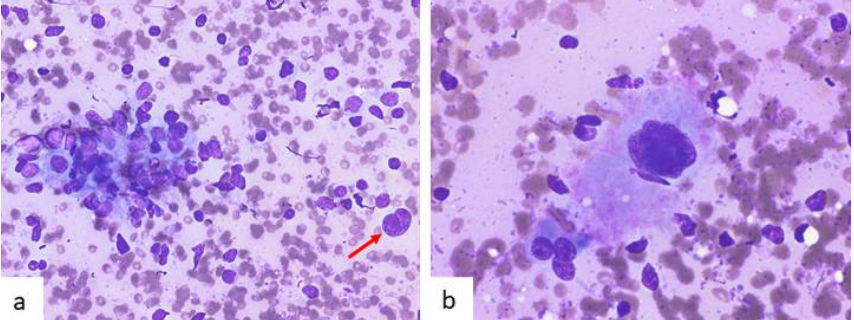
Figure 4. Cytological images in case of HV-CD. ( a ) The image shows an aggregate of FDCs (left) as well as a large single one with no cytoplasm and a nuclear indentation (red arrow) (Diff-Quik, ×200). ( b ) Some FDCs are dysplastic with very large size and irregular nuclear contours (Diff-Quik, ×600). Most nuclei have regular borders with fine chromatin, small nucleoli and occasional binucleation. Hidvegui et al. described a peculiar coarse chromatin (“wrinkled tissue pa- per”) [47] that has been rarely reported by others [67,68]. Nucleoli sometimes can be large, and nuclear grooves and indentations can be prominent (Figure 4). Large binucleated cells with relevant nucleoli may be misinterpreted as Reed–Sternberg cells [53,56,60]. In fact, HL is one of the main pitfalls in the cytological diagnosis of CD. An extreme form of FDC change are the so-called giant “dysplastic” cells. They are also present in the PC variant of CD. At least one cytological report described them [50] . Smears rarely show neutrophils,